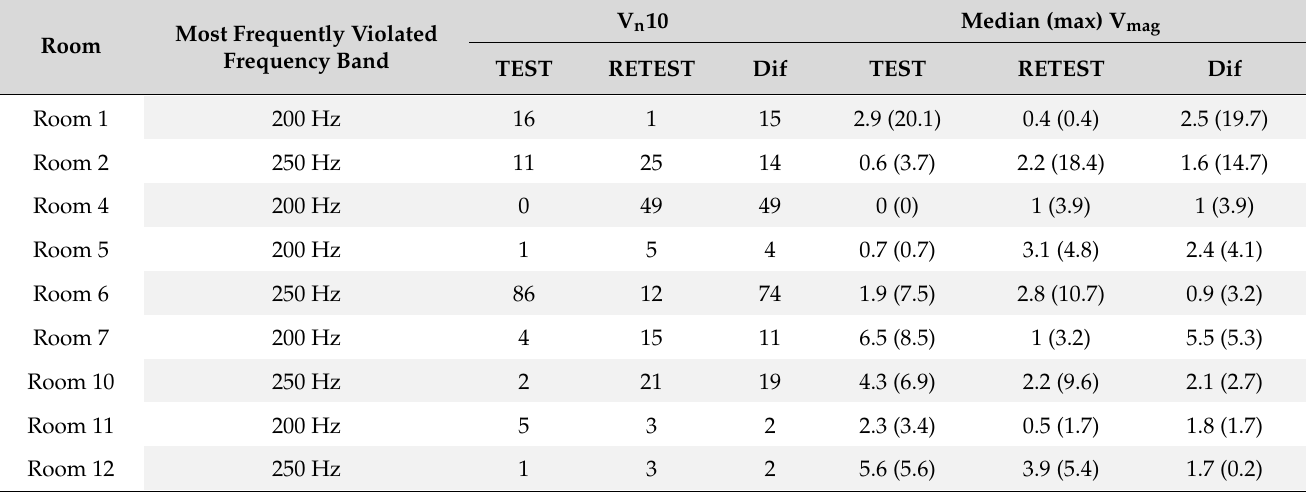
Table 3. Ambient noise test–retest V n 10 and median (and max in parenthesis) V mag values in 9 rooms for the most frequently violated frequency in either test or retest measurements. V n